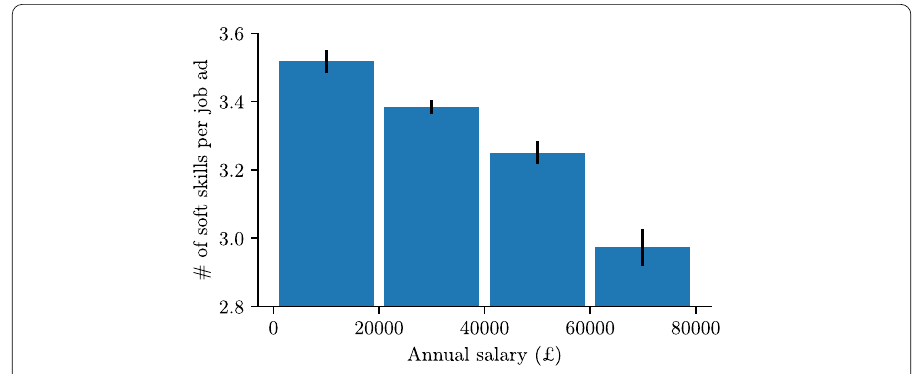
Figure 3 Low-paid job ads contain, on average, more soft skills than high-paid job ads. Bars show the average number of soft skills for the ads in four different salary groups, and the error bars indicate the 95% confidence intervals obtained via bootstrap re-sampling with